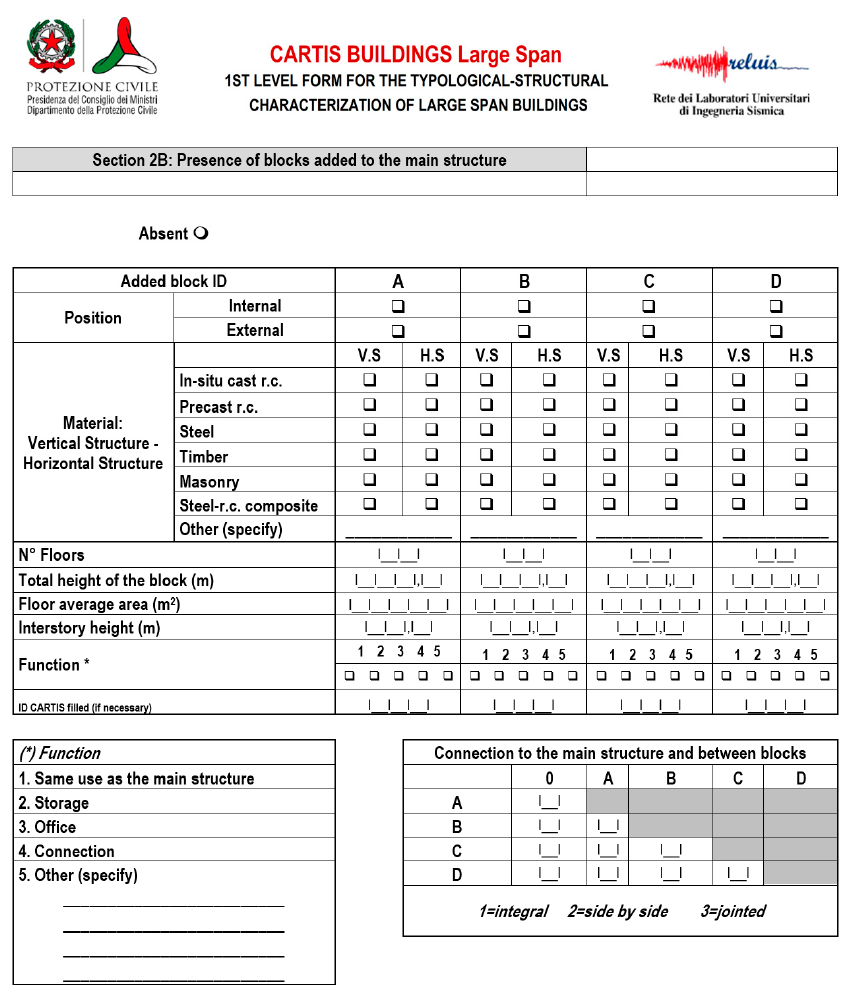
Figure 19. Section 2B CARTIS-Building: Presence of blocks added to the main structure (English version [19]).